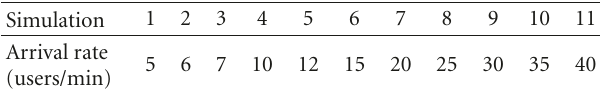
Table 2: Arrival rates values used in the simulations. Simulation 1 2 3 Arrival rate